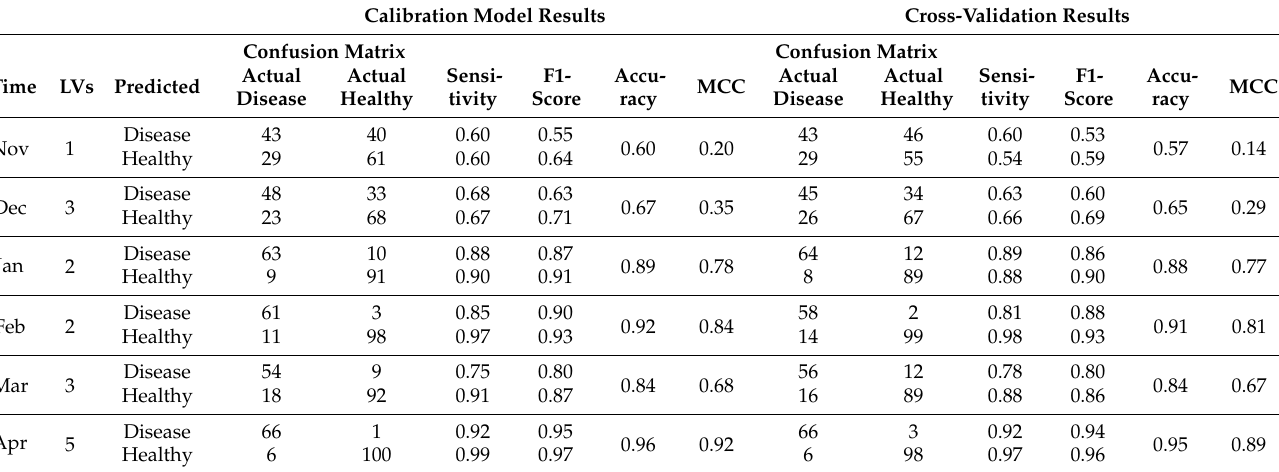
Table 3. PLS-DA results for Pinot Noir. Sample number: Disease = 72, Healthy =